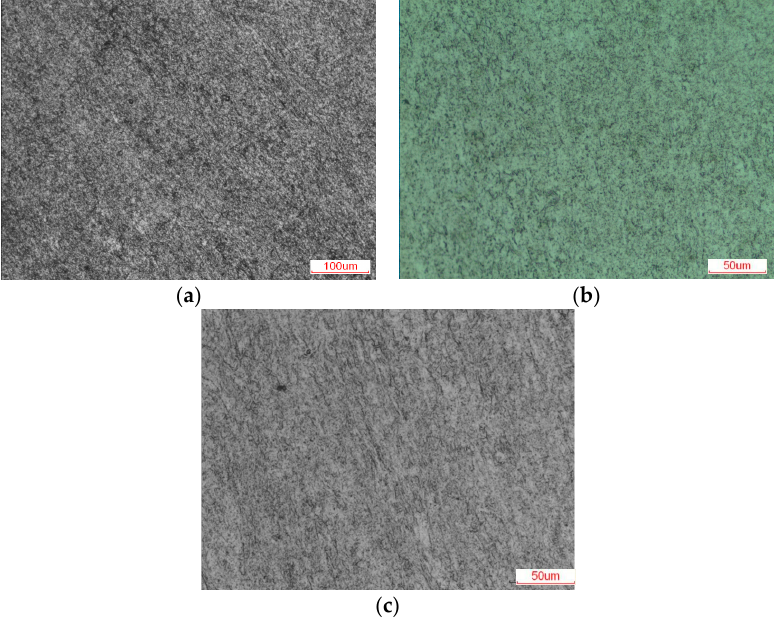
Figure 5. Optical micrographs of cold rolled CP-Ti: ( a ) AS (As-received) + CR; ( b ) 4p-ECAP + CR; ( c ) 8p-ECAP + CR.